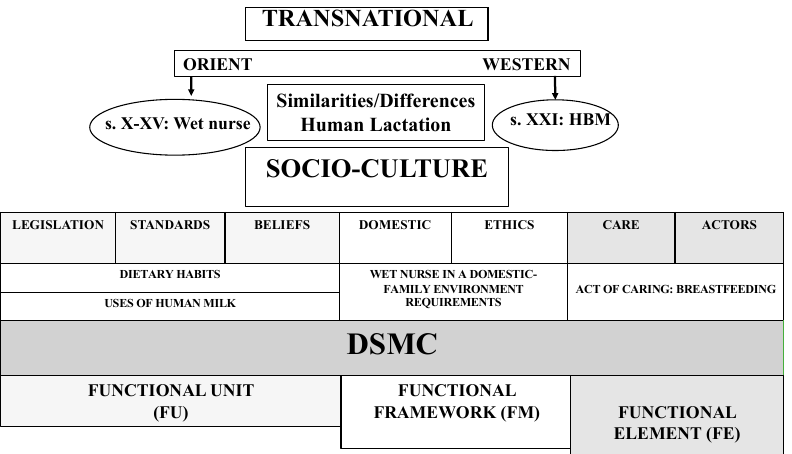
Figure 1. Theoretical dialectical structural model of care (DSMC): application of its structures. Source: authors’ own elaboration.